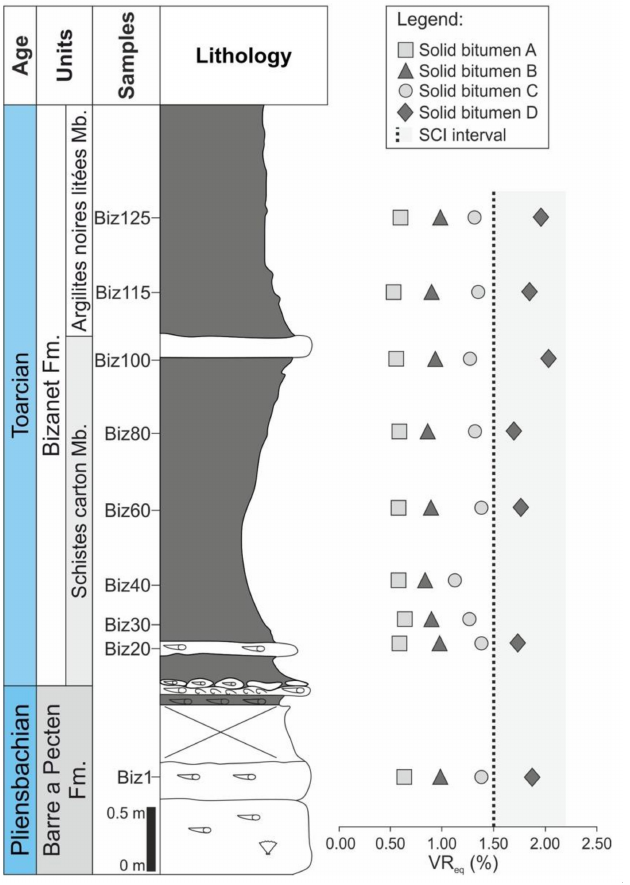
Figure 8. ( A – D ) Photomicrographs of solid bitumen D in whole-rock polished blocks under reflected white light.